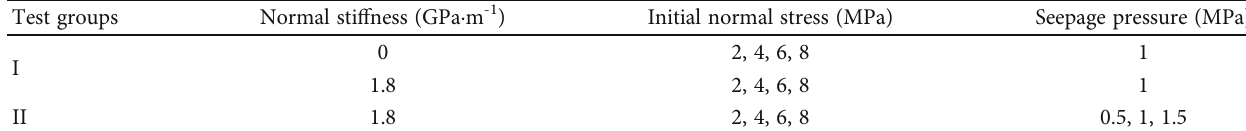
Table 1: Joint shear- fl ow coupling test protocol.